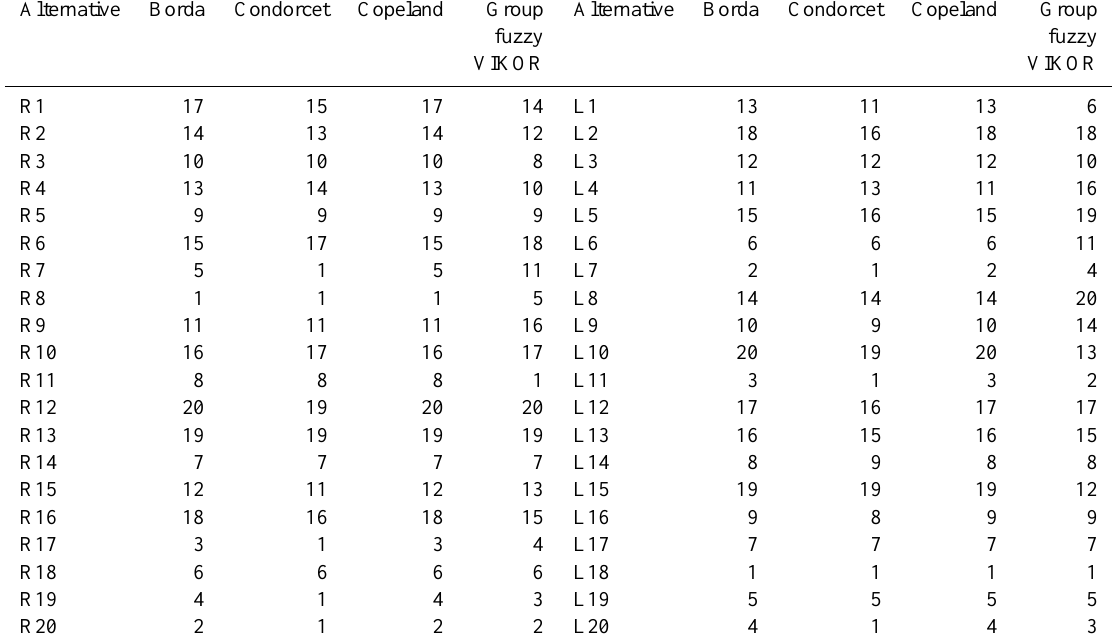
Table 4. Comparison of evaluated ranks by GDM approaches. Alternative Borda Condorcet Copeland Group Alternative Borda Condorcet Copeland Group fuzzy